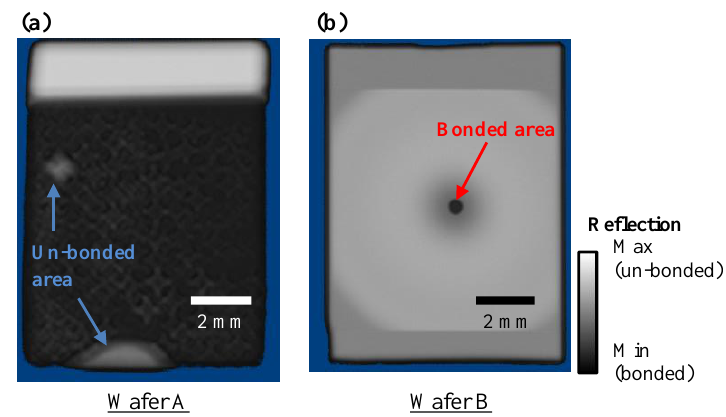
Figure 10. Observation of bonded interface with scanning acoustic microscope (SAM). Obtained imaging map for the bonding of a pair of SOI wafers A ( a ) and B ( b ).